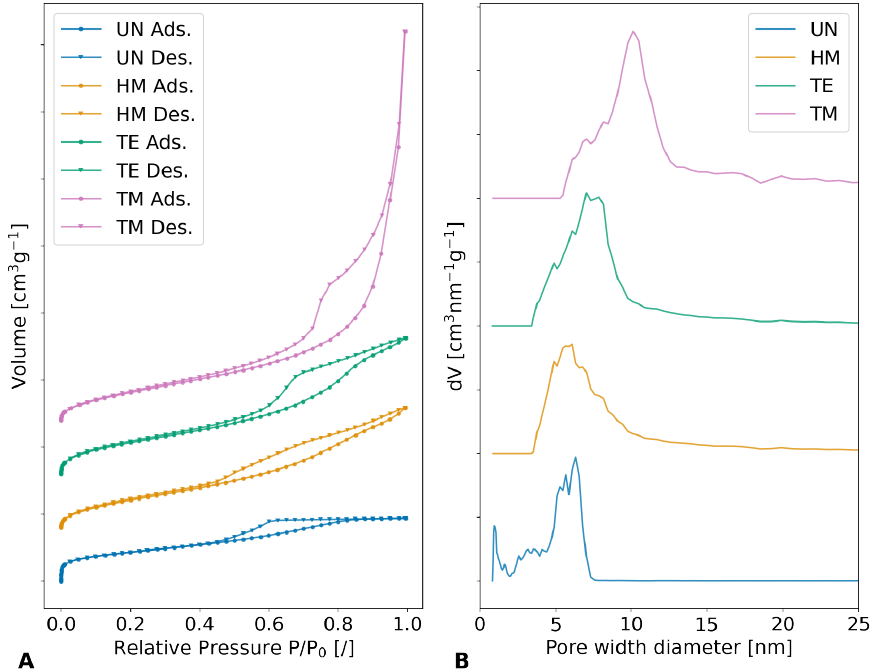
Figure 9. Results with a vertical shift of the unmodified UN (blue), hexamethyldisilazane-modified HM (orange), triethylchlorosilane-modified TE (green), and trimethylchlorosilane-modified TM (pink) samples of ( A ) nitrogen adsorption (Ads.) and desorption (Des.) isotherms, as well as their respective specific surface areas; ( B ) the NLDFT evaluations with equilibrium model and cylindrical pore geometry. The pore width diameter showed an overall decrease in the order of the TM, the TE, the HM, and the UN samples, while a noticeable change in isotherms was visible.